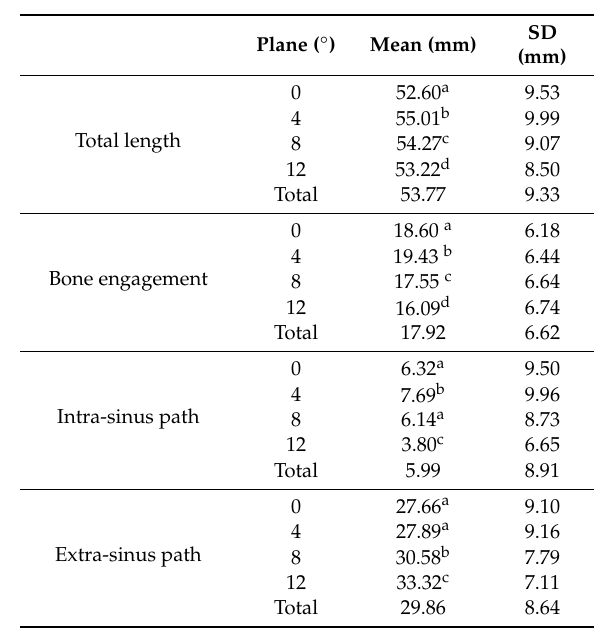
Table 2. Measurements on di ff erent planes. SD = standard deviation. All the lines are included. a, b, c indicate significant di ff erences between plane 0, 4, 8, and 12 for each variable (total length, bone engagement, intra-sinus path, extra-sinus